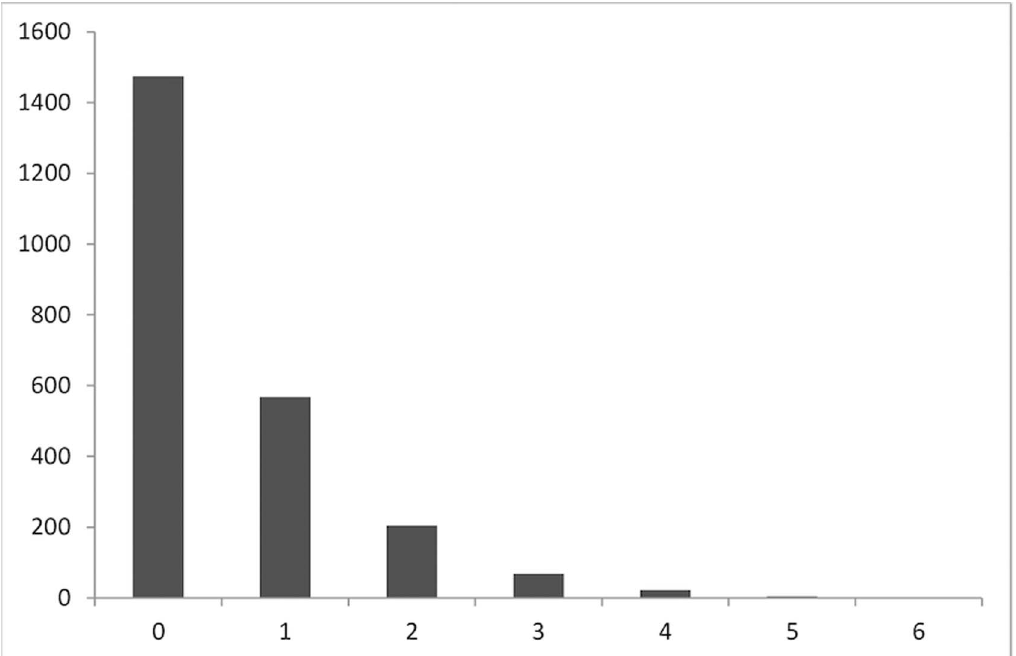
Figure 1. Frequency distribution of disinhibitory behavior scores. doi:10.1371/journal.pone.0073574.g001 PLOS ONE |